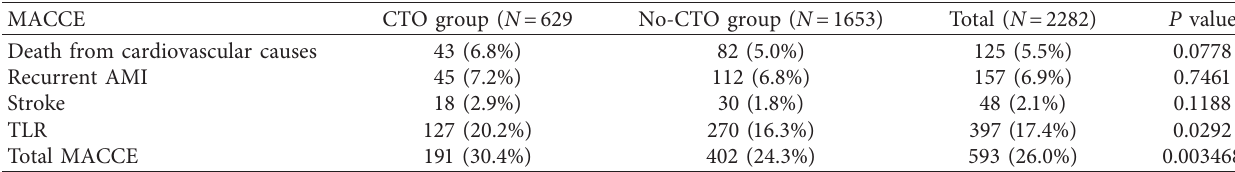
Table 3: Primary outcomes for CTO group and no-CTO group.